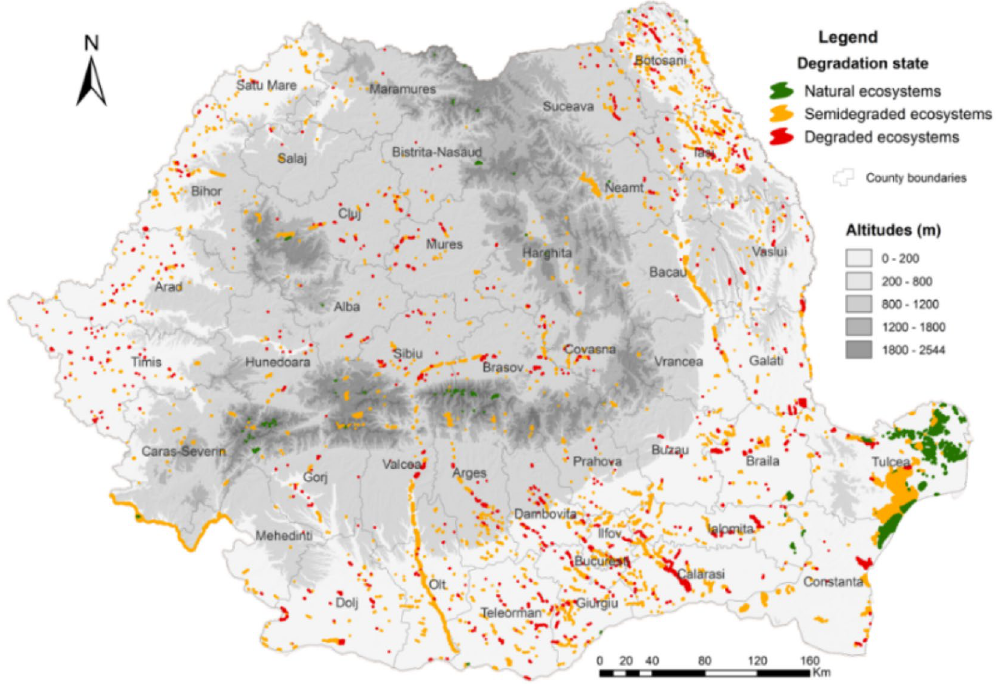
Figure 2. Distribution of lentic ecosystems on the Romanian territory according to the altitudinal stages (this map was created with Arc GIS 10.5